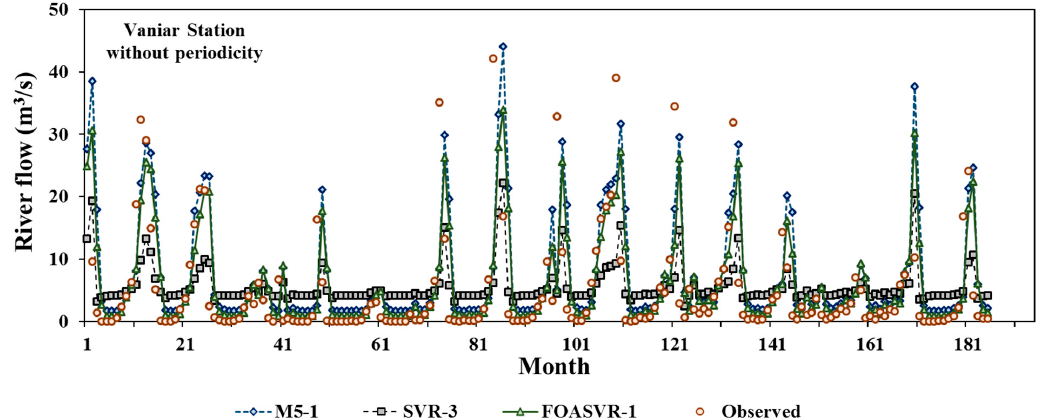
Figure 7. The observed and forecasted monthly river flows for Vaniar station without periodicity.